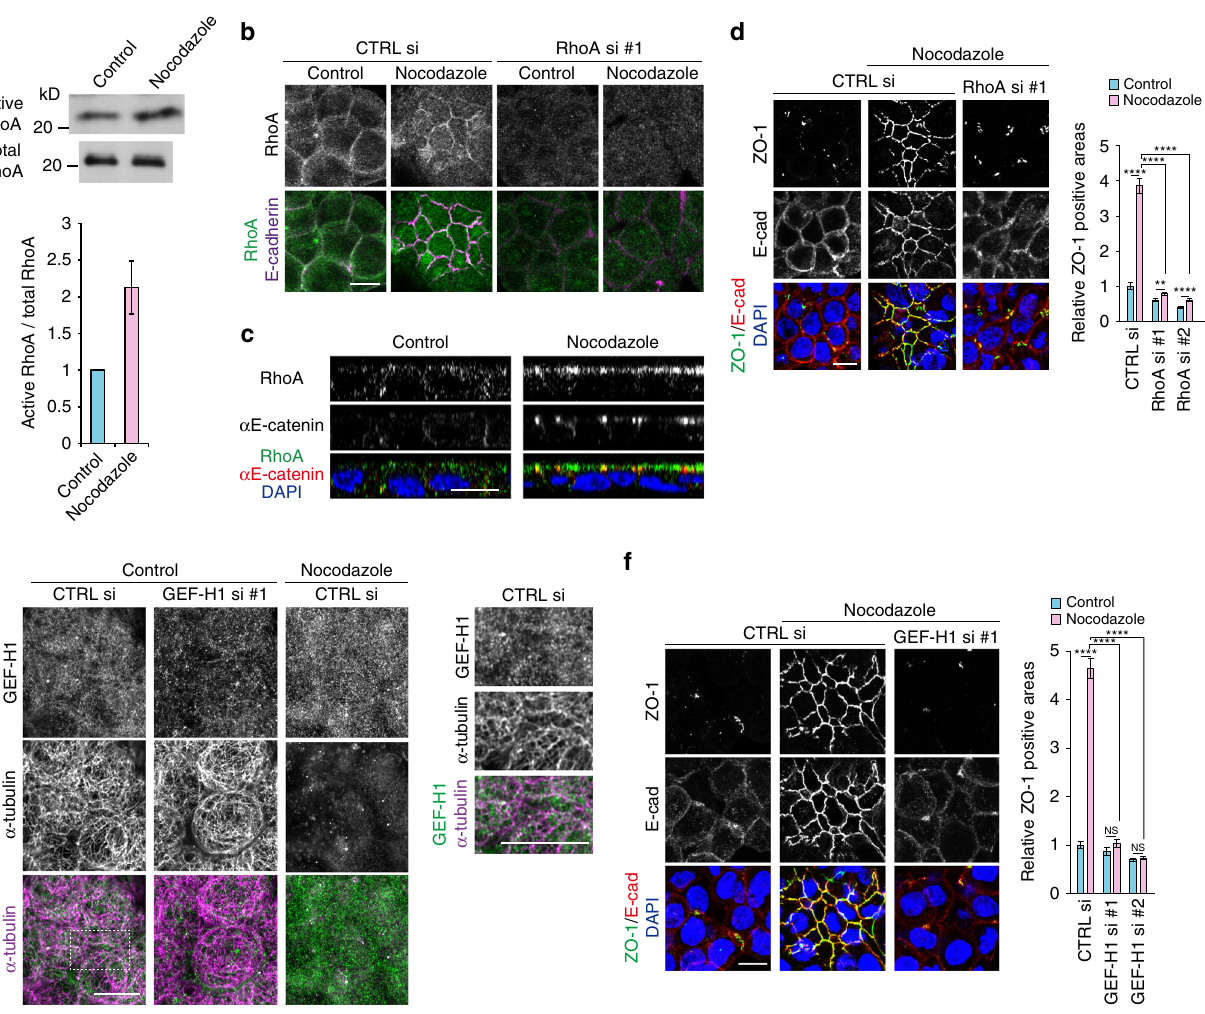
Fig. 2 RhoA upregulation is essential for apical junction formation. a Assay of RhoA activity using the lysates of HT29 cells treated or not treated with nocodazole. Active and total RhoA were detected by immunoblotting for anti-RhoA antibody. The graph shows the ratio of active to total RhoA, assessed by densitometric scanning of blots. n = 5 independent experiments, mean ± SEM. b Immunostaining for RhoA and Ε -cadherin in HT29 cells transfected with control (CTRL) or RhoA siRNA (si). c Lateral views of HT29 cells immunostained as in b . d Staining for ZO-1, E-cadherin and DNA in HT29 cells transfected with CTRL si or RhoA si. Relative ZO-1 positive areas are also shown. n = 65, 65, 71, 70, 66 and 71 fi elds for nocodazole-untreated (control) and -treated cells, which were transfected with CTRL si, RhoA si #1 and RhoA si #2, respectively, pooled from two independent experiments. ** P = 0.0011, **** P < 0.0001 by two-tailed Mann – Whitney U -test. e Immunostaining for GEF-H1 and α -tubulin in HT29 cells transfected with GEF-H1 siRNA. Images were obtained with Airyscan. Part of the control image is enlarged at the right. f Staining for ZO-1, E-cadherin and DNA in HT29 cells transfected with CTRL or GEF-H1 siRNAs. Relative ZO-1 positive areas are also shown. n = 69, 67, 68, 68, 69, and 72 fi elds for nocodazole-untreated and -treated cells, which were transfected with CTRL si, GEF-H1 si #1 or GEF-H1 si #2, respectively, pooled from two independent experiments. **** P < 0.0001 by two-tailed Mann – Whitney U -test. NS, not signi fi cant. Scale bars, 10 μ m. See also Supplementary Fig. 2